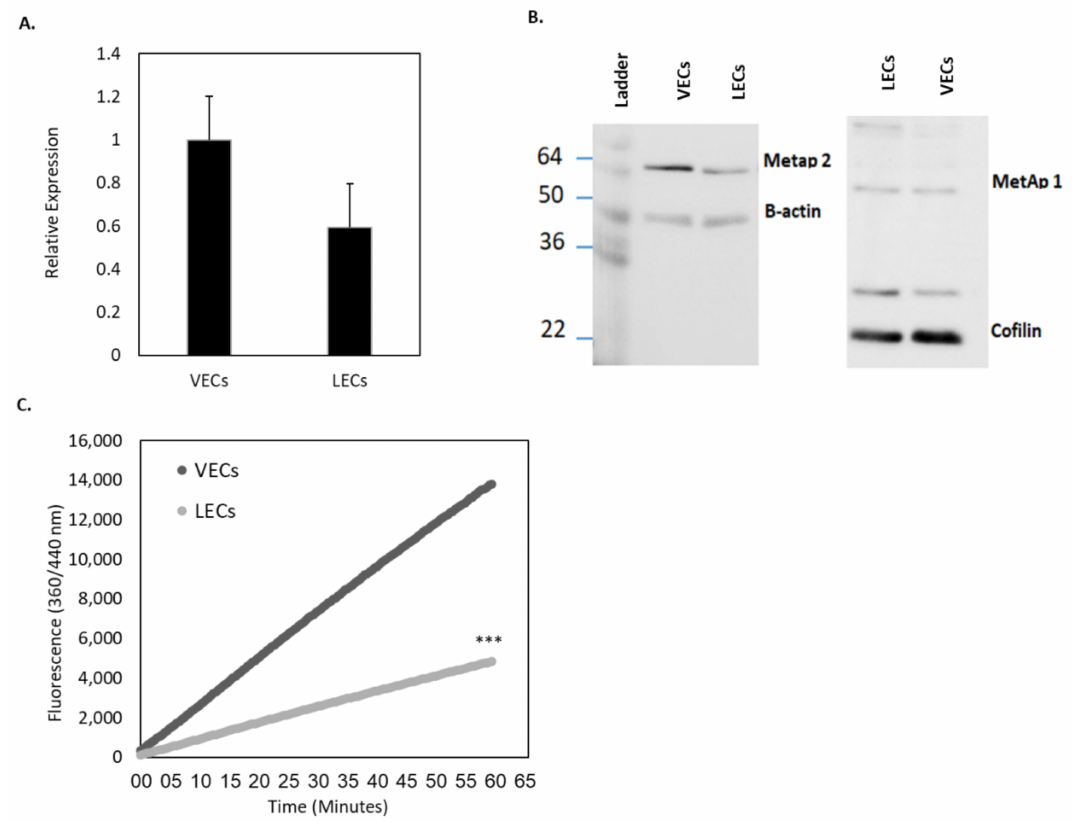
Figure 2. Basal MetAp2 activity and expression in LECs compared with VECs. ( A ) The MetAp2 mRNA levels in LECs (HMVEC-dLyAd cells) is ~60% of the mRNA levels in VECs (HUVECs), as measured by qRT-PCR (5 µg), n = 3 . ( B ) Western blot analyses for determining the expression of MetAp2 in both cell lines. ( C ) Measurement of the basal activity of MetAp2 in HUVECs and HMVEC-dLyAd cells. A homogenate containing an equal number of cells was added to an L-Met-AMC solution (250 µM). The reaction was monitored for 1 h via the fluorescent quantification of the cleaved substrate. MetAp2 in HMVEC-dLyAd cells showed over a 65% reduction in the enzymatic ability to cleave labeled methionine when compared with HUVECs. The results were normalized to the total cell number. *** p < 0.001. The results are presented as mean ± SEM.